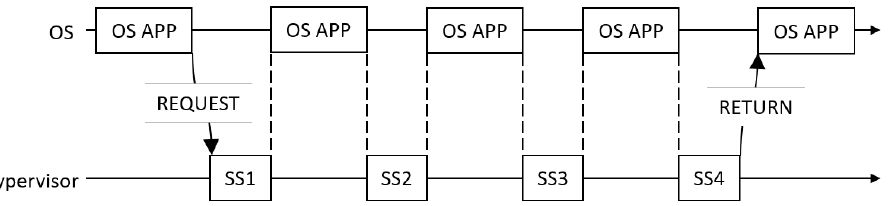
Figure 4. A time table of secure service execution—on fine-grained